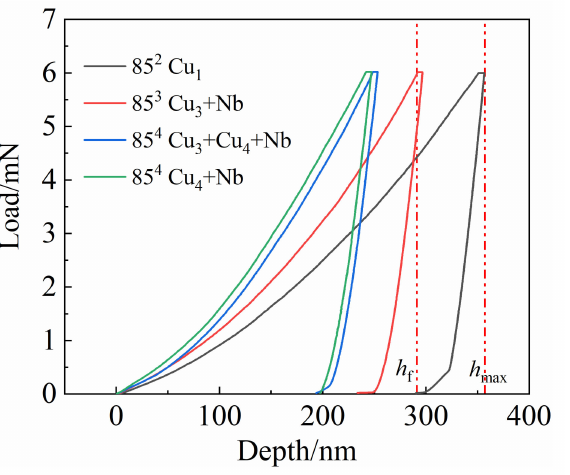
Figure 6. Typical load/displacement curves for different test areas of Cu-Nb composite wires.